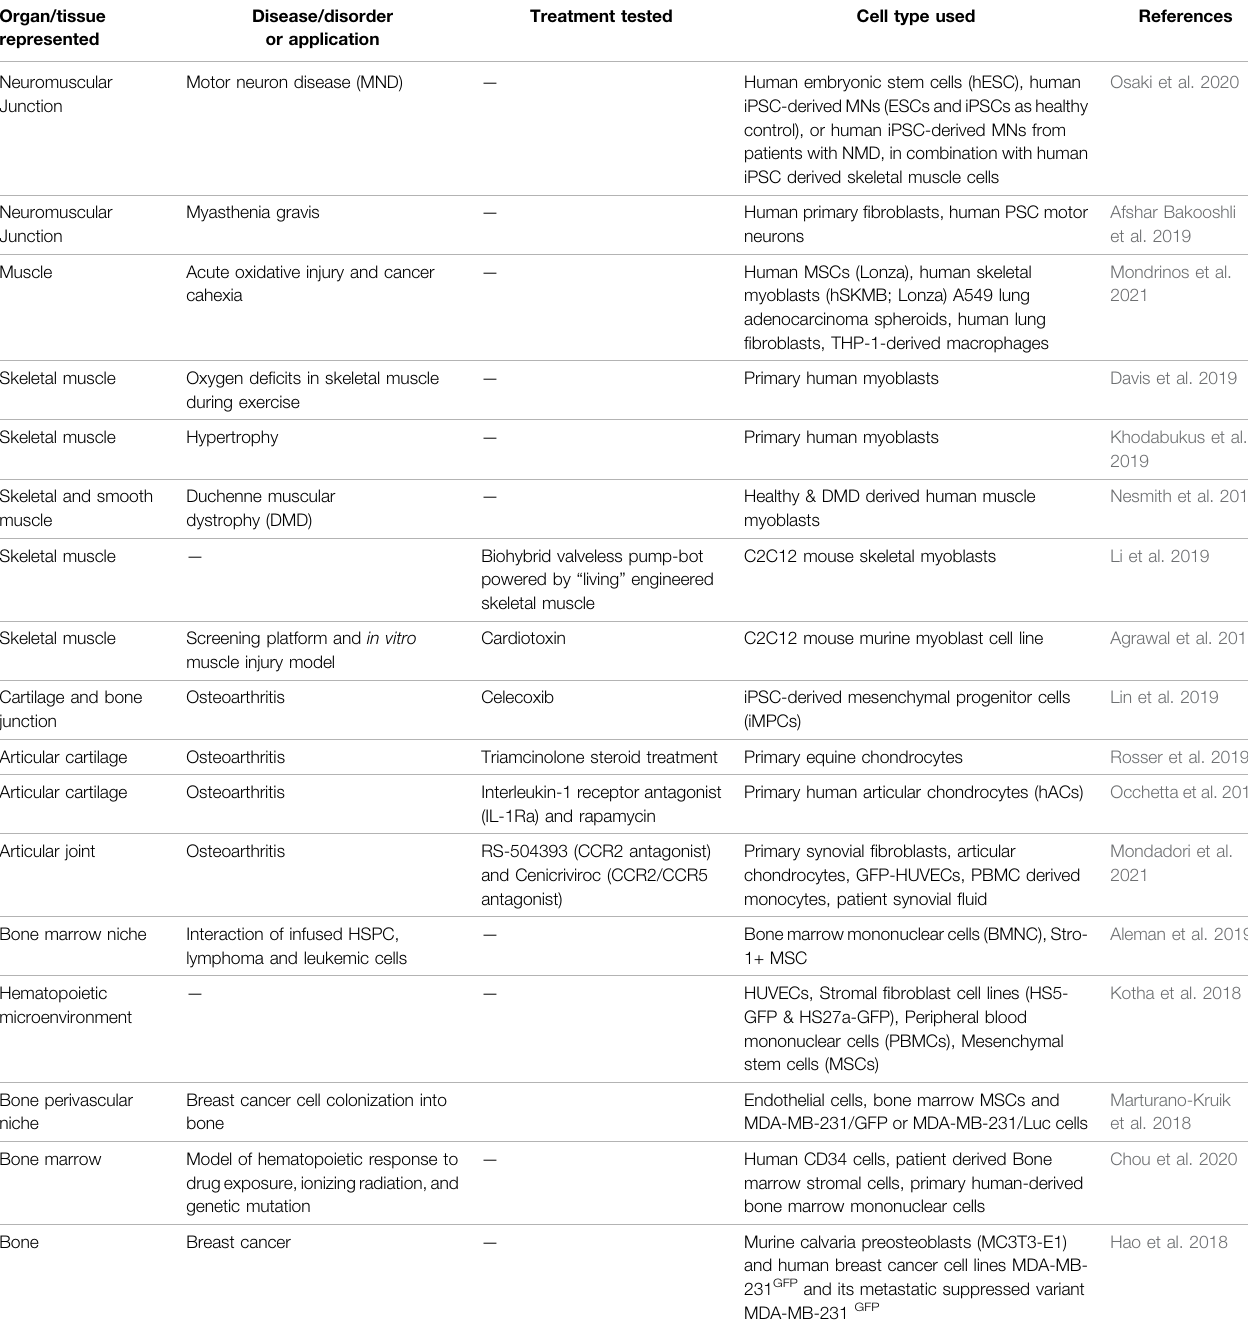
TABLE 2 | Examples of tissue-on-a-chip models of musculoskeletal tissues and organs. Organ/tissue